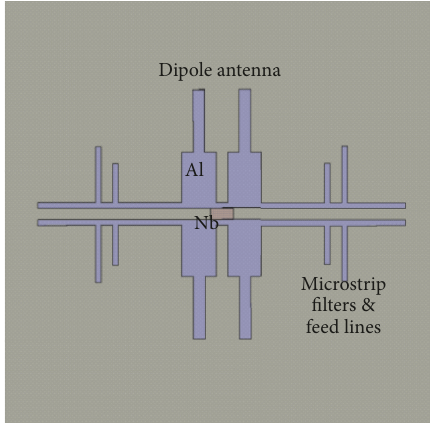
Figure 1: Antenna geometry (not to scale) coupled to a Nb micro- bolometer. The squared background corresponds to a pixel area of 20 × 20 𝜇 m 2 .